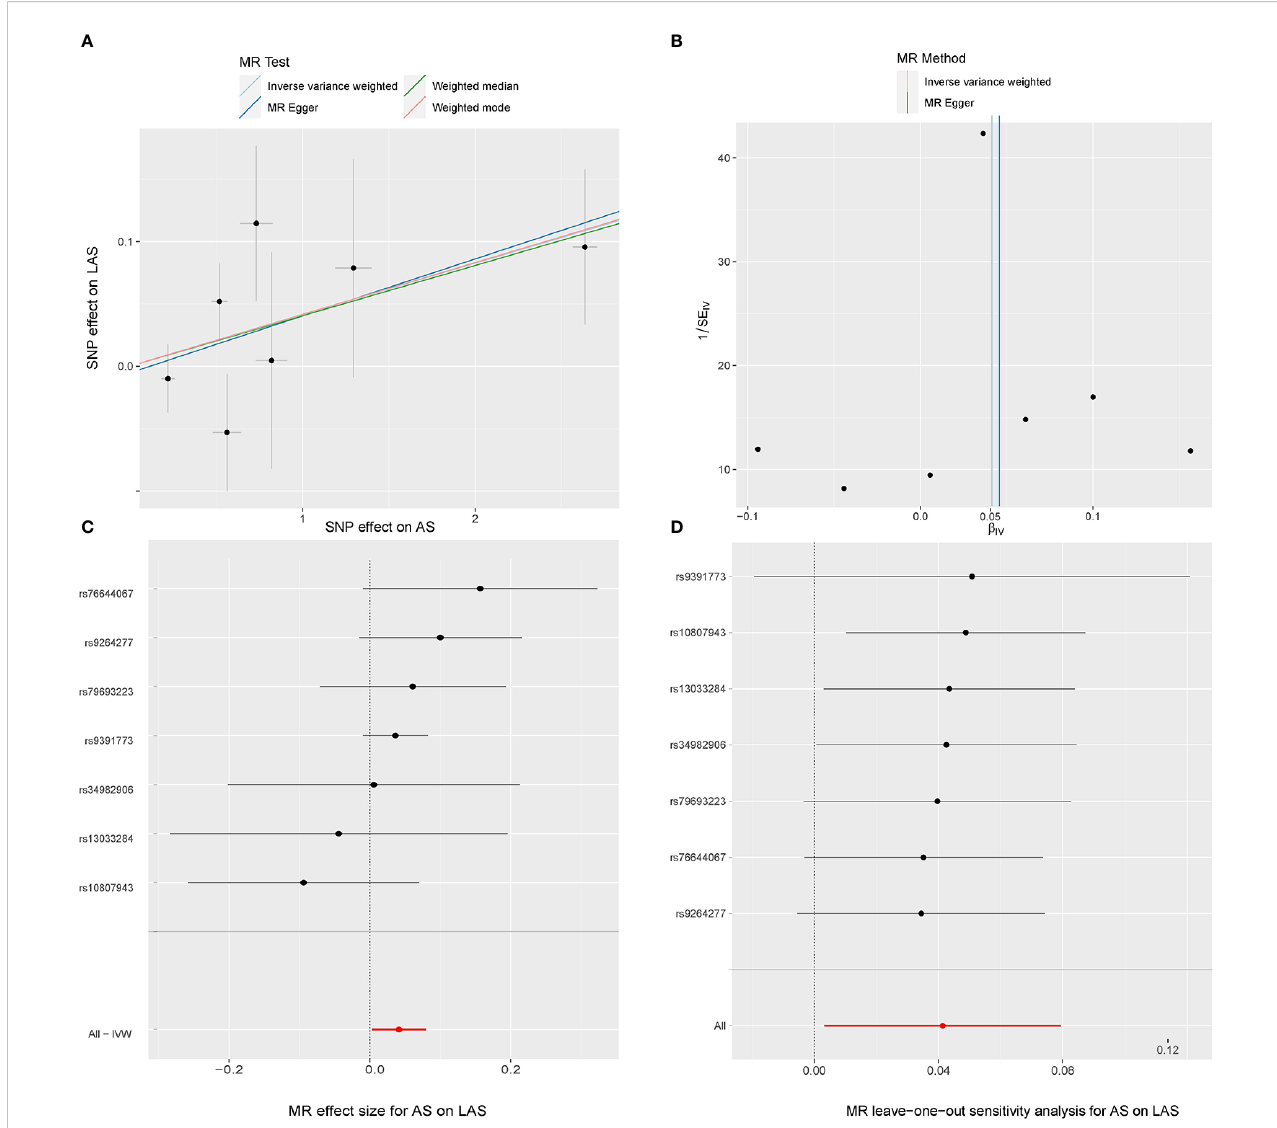
FIGURE 4 MR study of the effects of AS on LAS. Scatter plot (A) , funnel plot (B) , forest plot (C) , and leave-one-out sensitivity analysis (D) of the effect of AS on